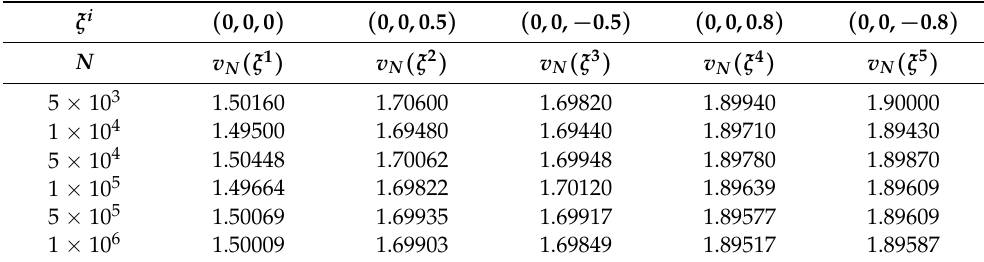
Table 2. Results for Problem 2 (in Example 1).